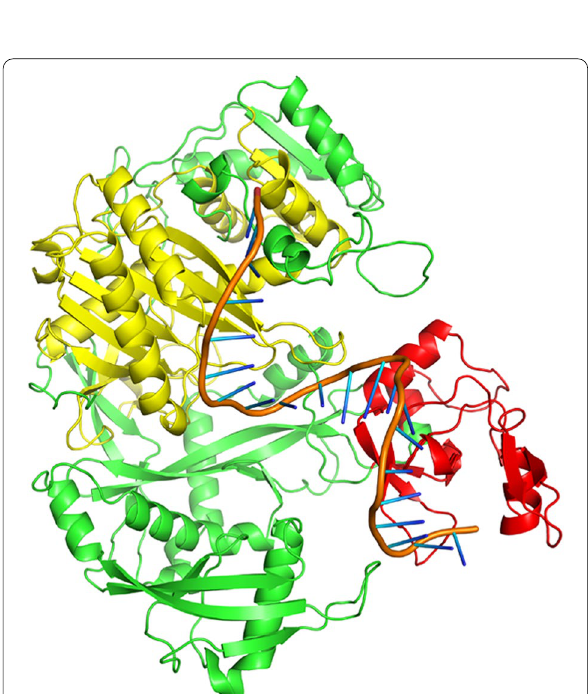
Fig. 6 A docked complex of AGO2 and S10.3. RNA, PAZ, PIWI, and the remaining regions are represented in orange, red, yellow, and green colors, respectively